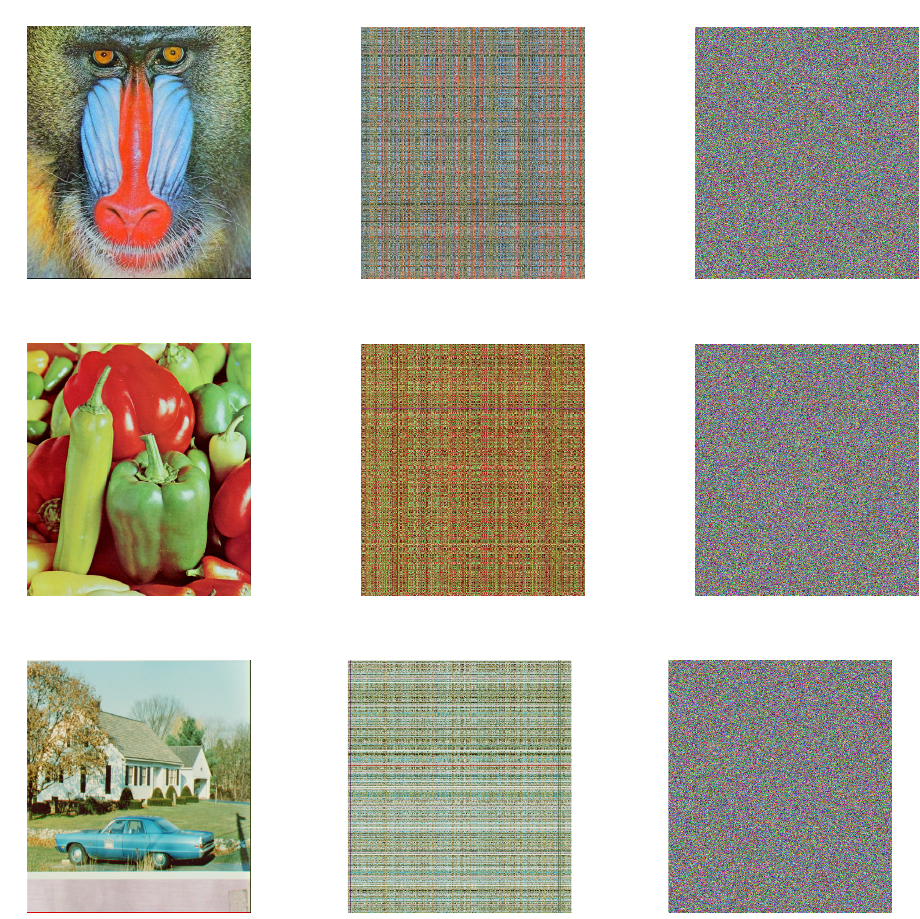
Figure 17. The plain, shuffled, and encrypted images for Baboon, Pepper, and House